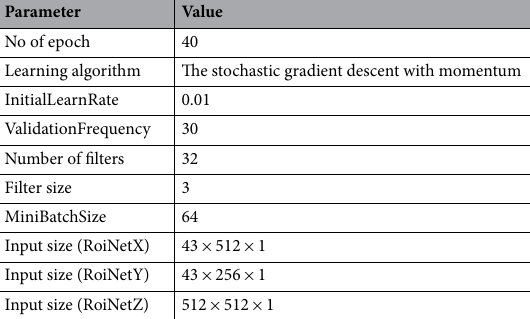
Table 1. The parameters used in the CNNs